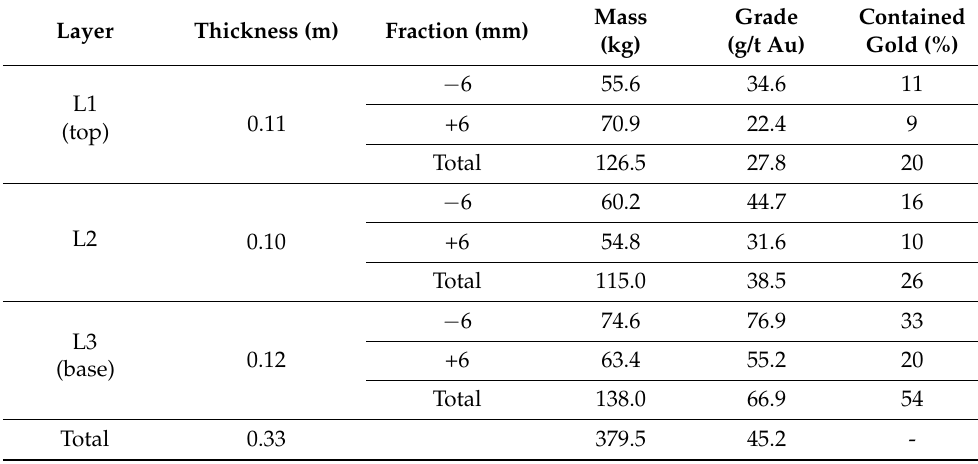
Table 8. Granulometric analysis (Sample SEG001) of three consecutive layers through the residue